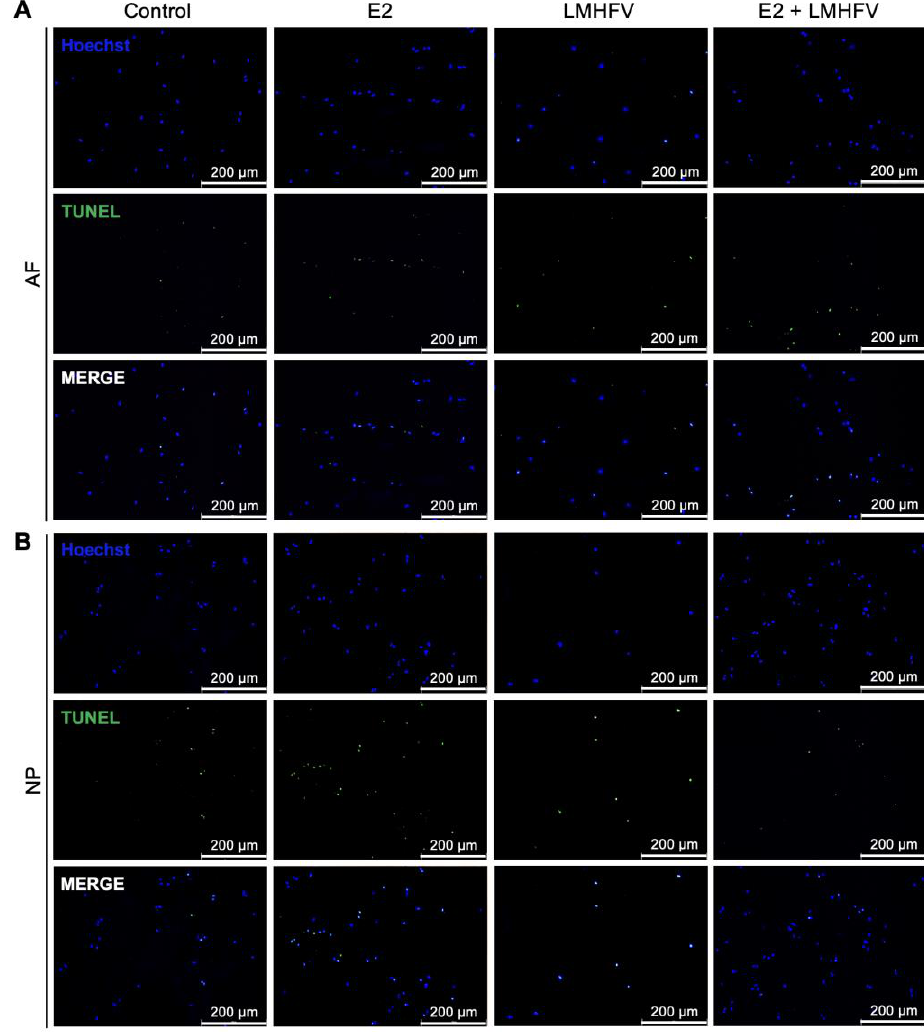
Figure A2. Cell apoptosis. Representative fluorescence microscopy images of Hoechst and TUNEL staining in the ( A ) AF and ( B ) NP after 21 days of organ culture. Cell nuclei are stained blue (Hoechst) and apoptotic cells green (TUNEL). Scale bar, 200 μm.